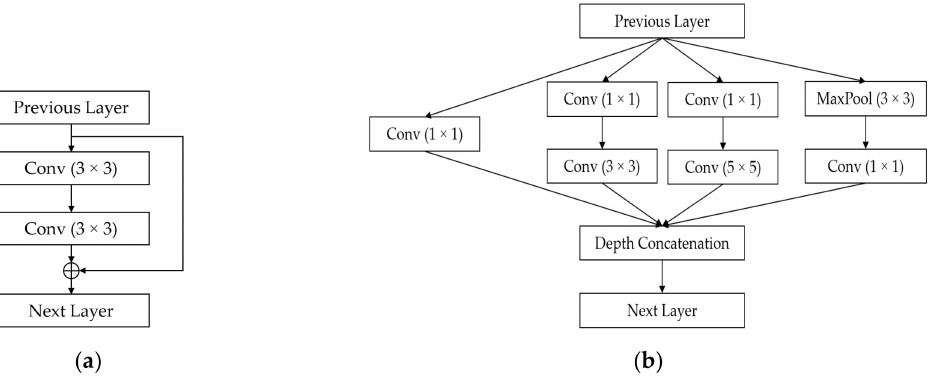
Figure 5. Structures of ( a ) the two-layer residual block in ResNet-18 and ( b ) the inception block in GoogleNet,